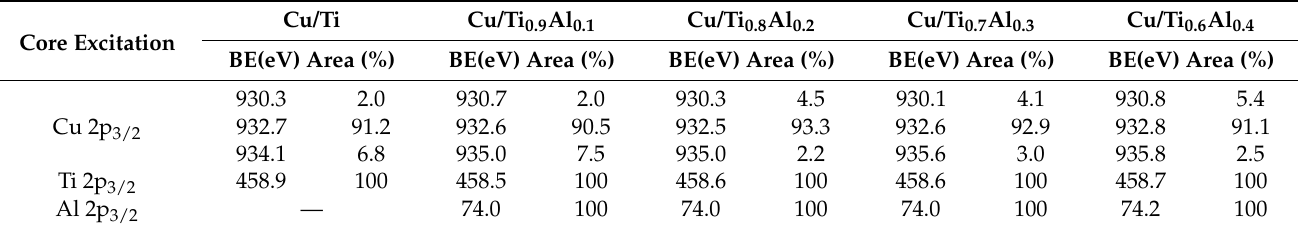
Table 3. XPS data of fresh